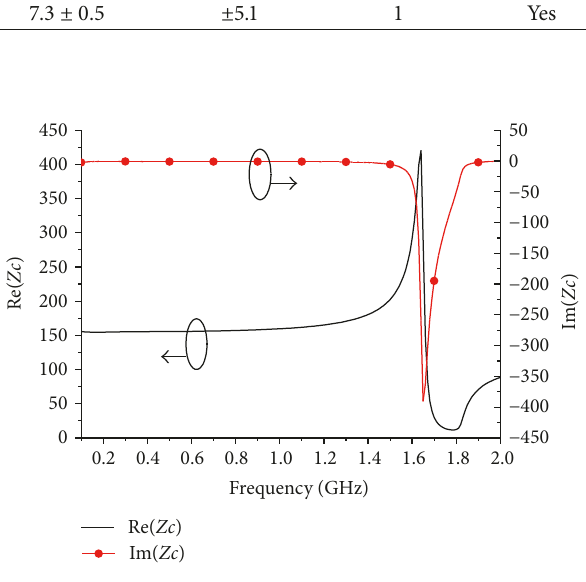
Figure 9: Simulated impedance of proposed 158.1 Ω transmission